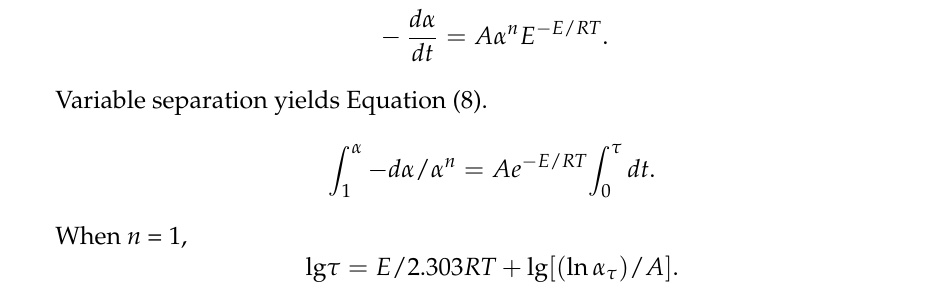
Figure 5. Plot of apparent activation energy ( E ) for BIIR decomposition in air as a function of α.